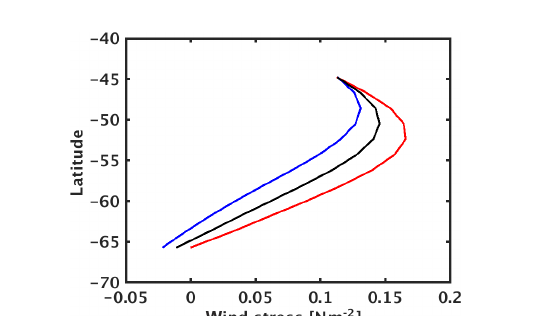
Figure 4. Impact of the meridional surface temperature gradient between 30 and 80 ◦ S on the Southern Hemisphere wind stress intensity and position. The black curve shows the climatological mean of the zonal wind stress at the latitudinal range 45–65 ◦ S in December–February (seasonal mean over the period January 1948– August 2012) with NCEP1. The blue and red curves show the mean wind stress profile in years with a steeper temperature gradient (more than 1 standard deviation; red line) or in years with a flat- ter temperature gradient (more than 1 standard deviation; blue line). The meridional temperature gradient was estimated as the slope of a linear fit of the zonal mean temperature against